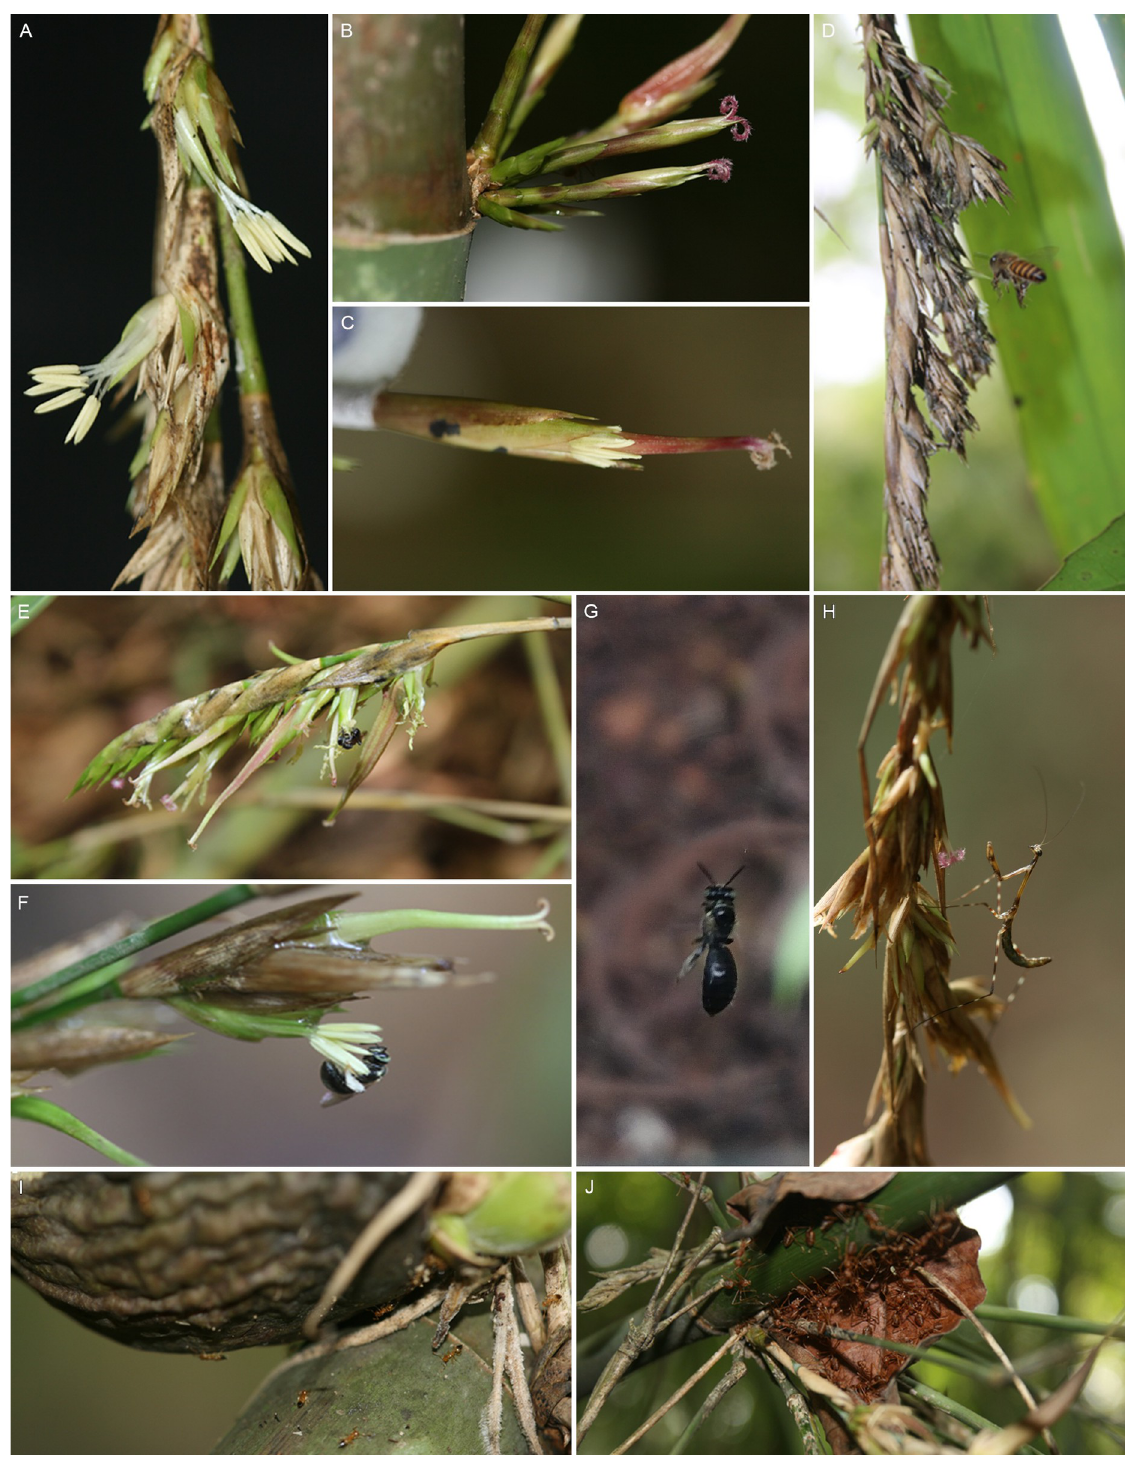
Fig 1. M . baccifera florets, visitors. A-C. Three types of florets, A. Male florets, B. Female florets, C. Bisexual florets showing protogyny (displaying drying stigma and emerging anthers); D-H Insect visits, D. A . cerana indica , E. T . iridipennis , F. H . taprabonae , G. B . cupulifera , H. Mantis E . indica ; I-J ants, I. C . biroi , J. O . smaragdina .